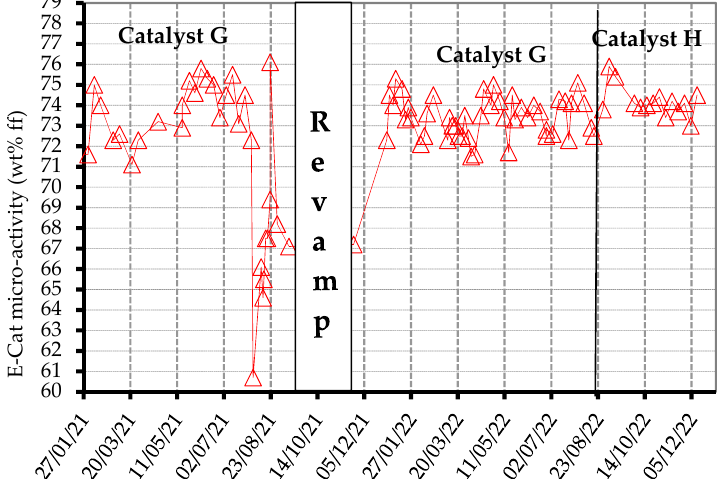
Figure 6. Micro-activity of E-Cat variation in time before and after the revamp.